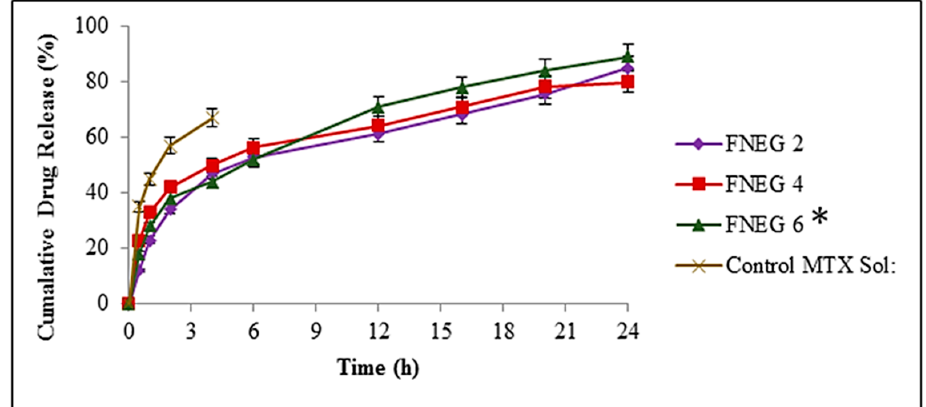
Figure 6. In vitro drug release of methotrexate-loaded nanoemulsion gel formulations. Data are expressed as mean ± SD; n = 3. One-way ANOVA followed by post hoc Tukey test ( p < 0.05), FNEG2, FNEG4, and FNEG6 (* p < 0.05).